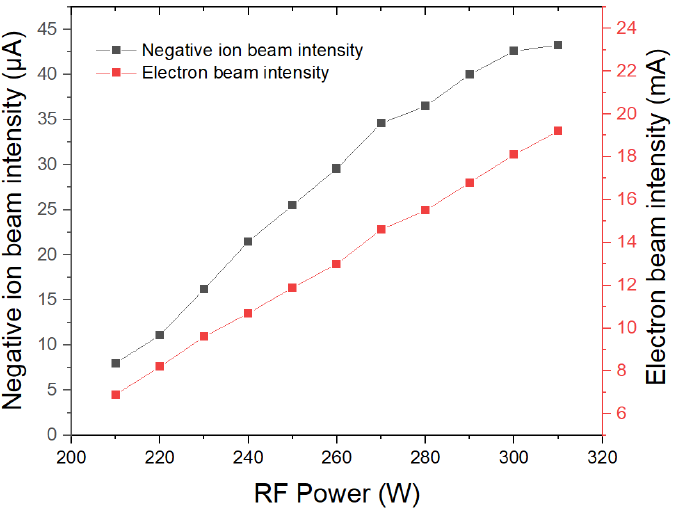
Figure 4. Negative ion beam intensity measured by Faraday cup vs. RF power.